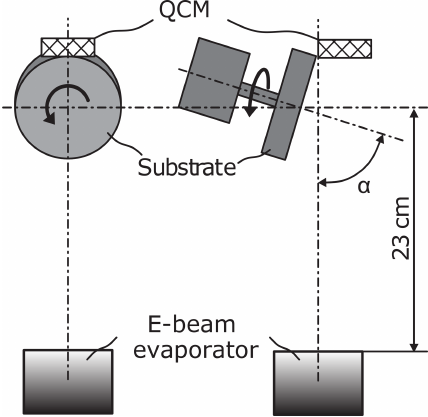
Figure 1. Setup of the GLAD apparatus adapted from Schossig (2012a). QCM – quartz crystal monitor.